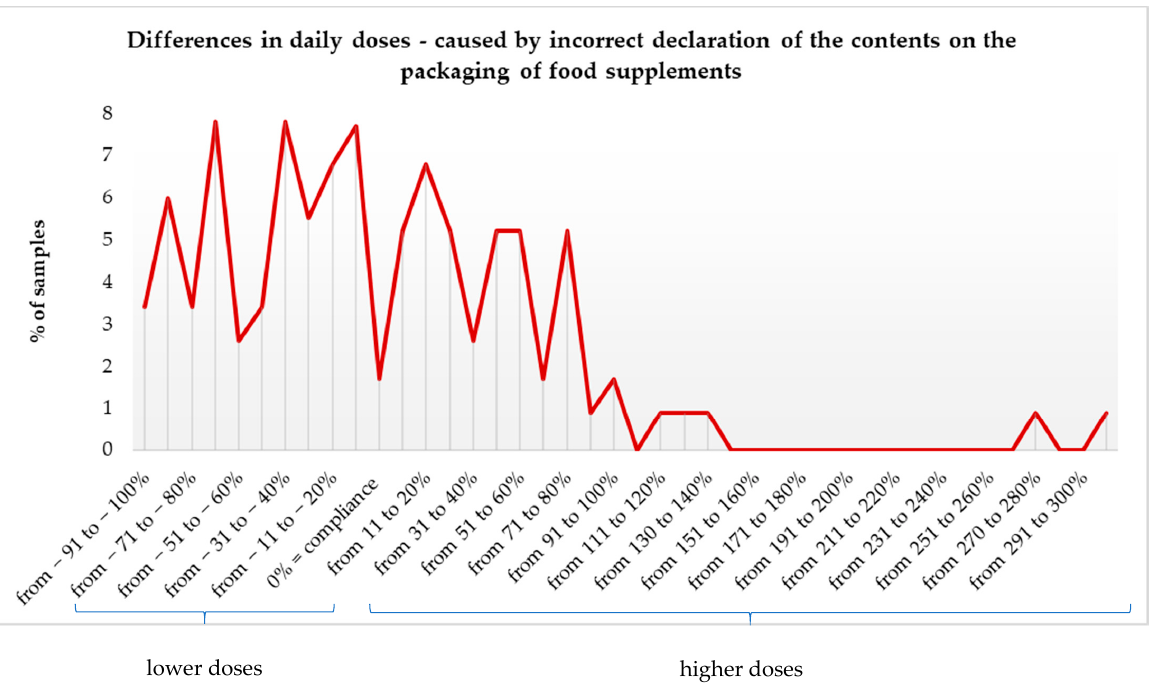
Figure 2. The percentage of food supplements and the difference in the actually taken magnesium dose, resulting from an incorrect declaration of the content.